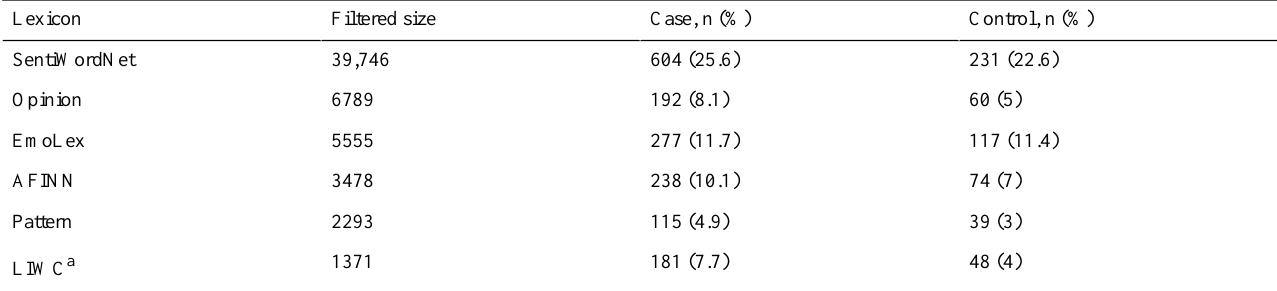
Table 6. Case and control keywords that appear in each sentiment lexicon, in descending order of lexicon (filtered) size. The total number of keywords for the case subcorpus is 2360 and for the control subcorpus is